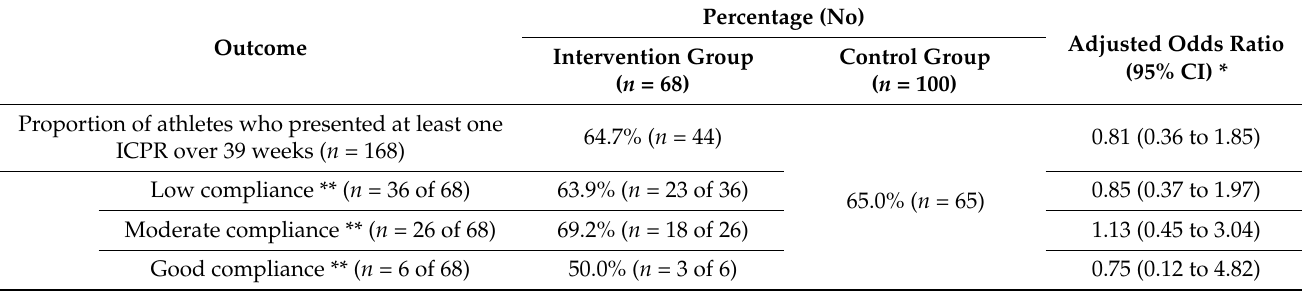
Table 3. Primary outcome results: comparison of the proportion of athletes who had at least one IPCR over the follow-up period (39 weeks) between the intervention and the control groups using an adjusted logistic regression model where the dependent variable was the occurrence (or non-occurrence) of at least one ICPR, and the dependent variables were the participant’s allocation, compliance with the AIPP, athletics exposure (training and competition), club, sex, age, and history of ICPR during the previous